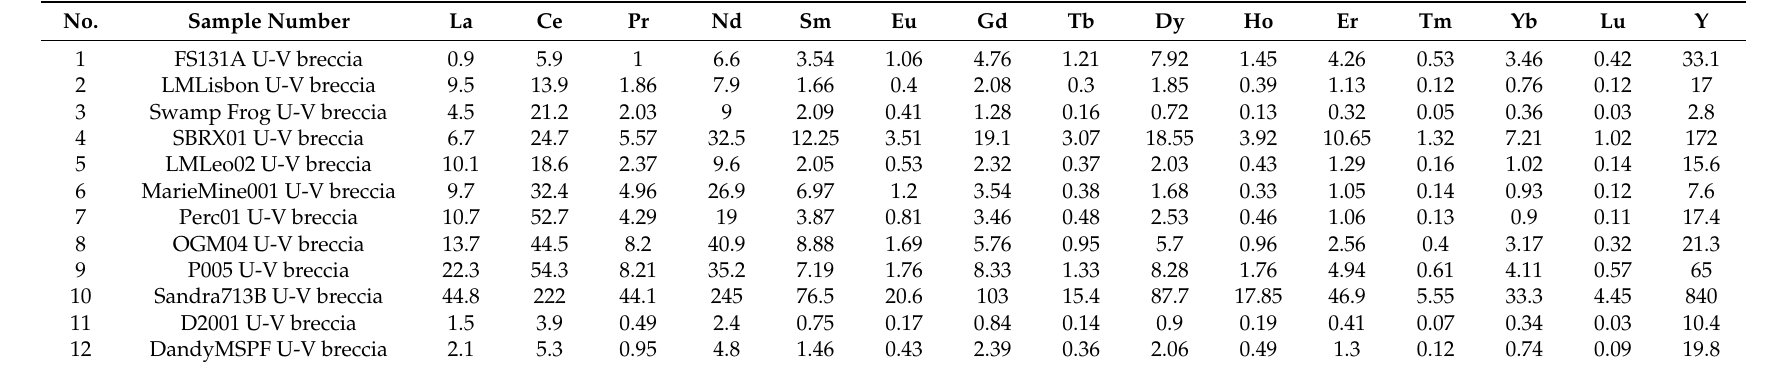
Table A3. REE plus Y ALS laboratory results with samples listed across the top of the table and elements to the side. The first 18 samples are mineralized breccia samples. The next 23 samples are the host rock, gangue minerals and unmineralized breccia samples. Values with < indicate the value was below the detection limit of the analysis. Values are in